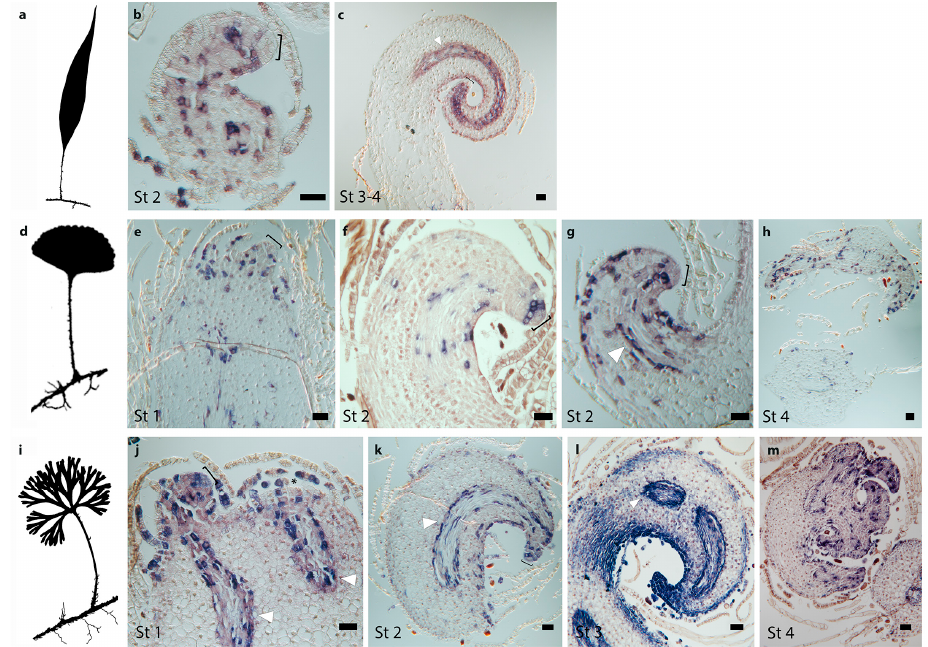
Figure 4. Cell division patterns as indicated by expression of Histone H4 genes during leaf development in species of the fern genus Elaphoglossum with simple and divided leaves. ( a–c ) Elaphoglossum lloense (simple leaves). ( b,c ) Expression patterns of ElH4 , longitudinal sections through the leaf primordium. ( b ) Expression in cells surrounding the leaf apical initial (LAI) and random cells throughout the primordium. ( c ) Expression in the apical region behind the LAI, in the procambium, and in the apical region of the margins. ( d–h ) Elaphoglossum peltatum f. standleyi (simple leaves). ( e–h ) Expression patterns of EpsH4 . ( e–g ) Longitudinal sections through the shoot apical meristem (SAM) and/or leaf primordium. ( e ) Expression in random cells throughout the primordium that do not include the LAI. ( f ) Expression in the apical region right behind the LAI and in random cells throughout the primordium. ( g ) Expression in the apical region behind the LAI, in the procambium, and in cells of the margins. ( h ) Transverse section of old developing leaf, little expression in petiole and random expression throughout the lamina. ( i–m ) Elaphoglossum peltatum f. peltatum